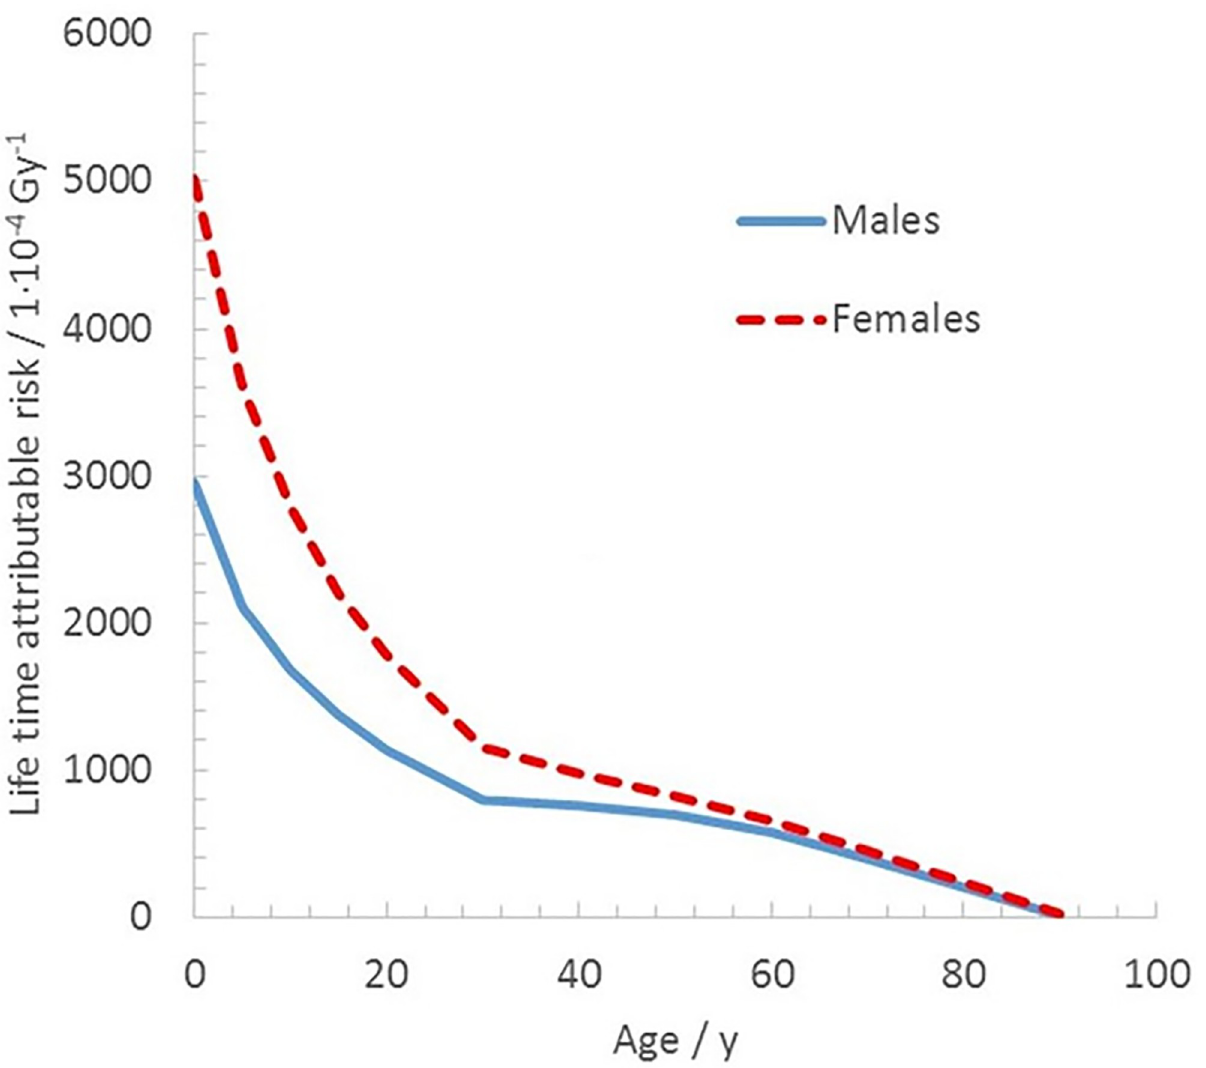
Fig 1. Interpolated continuous age-dependent LAR (10 − 4 Gy -1 ) for total cancers (except non-fatal skin cancers) for protracted radiation exposure as a function of age, taken from EPA (2011).